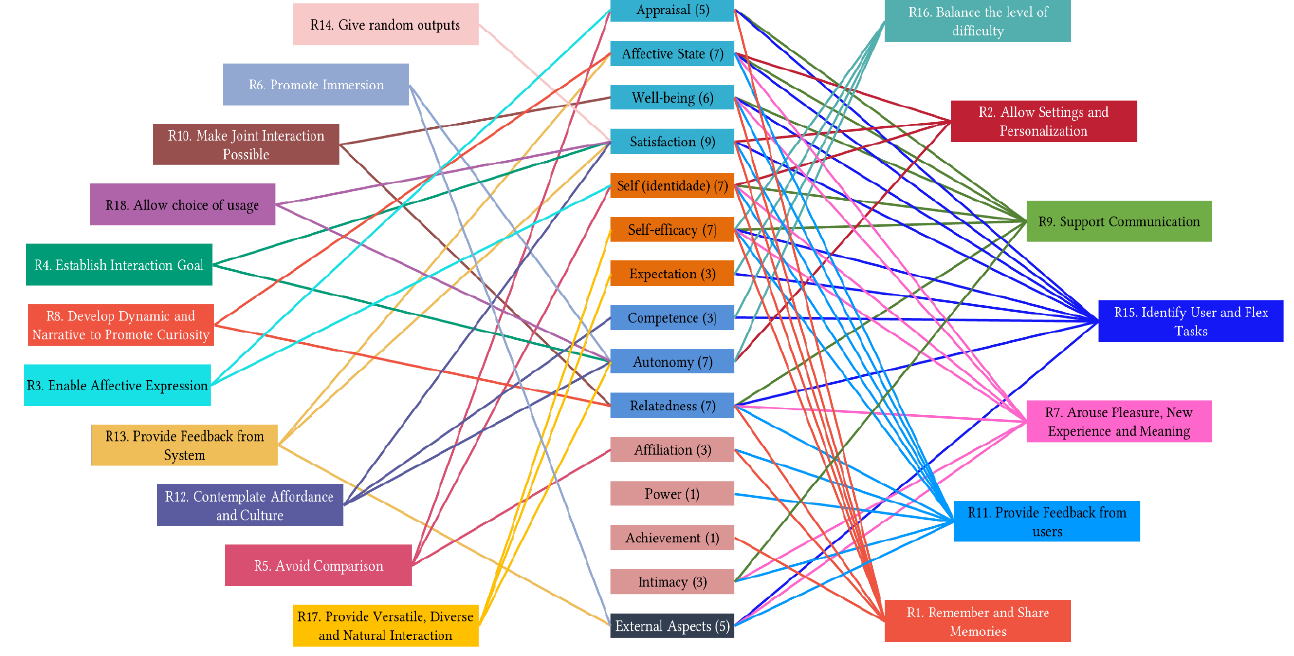
Figure 4. Relation between SDT’s aspect and the Design